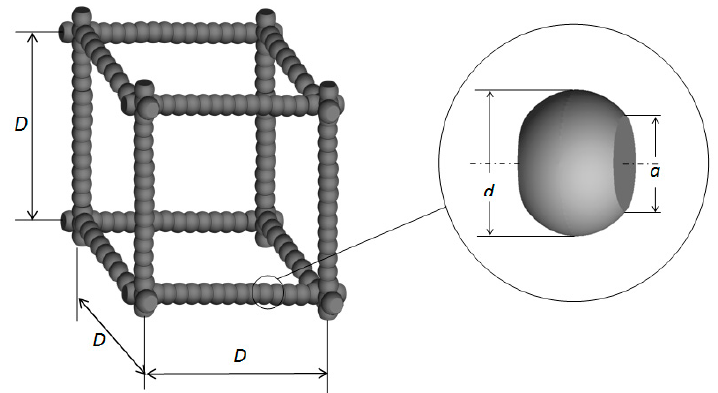
Figure 4. Diagram of cubic array model for coupled conduction in nano-skeletons and gas.